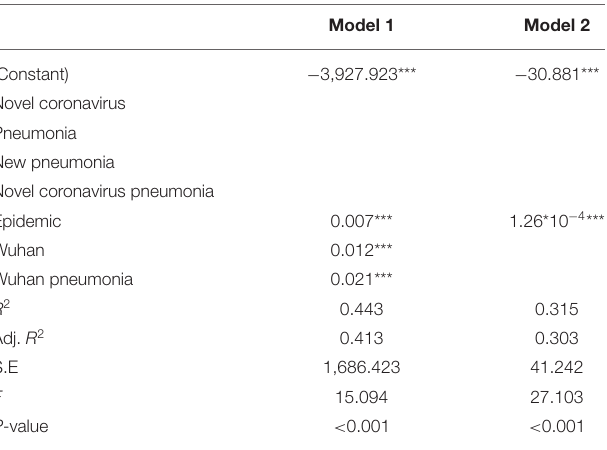
Model 1 ( Table 2 ): seven BDI-related keywords were used to predict new confirmed cases. Model 2 ( Table 2 ): seven BDI-related keywords were used to predict new death cases.